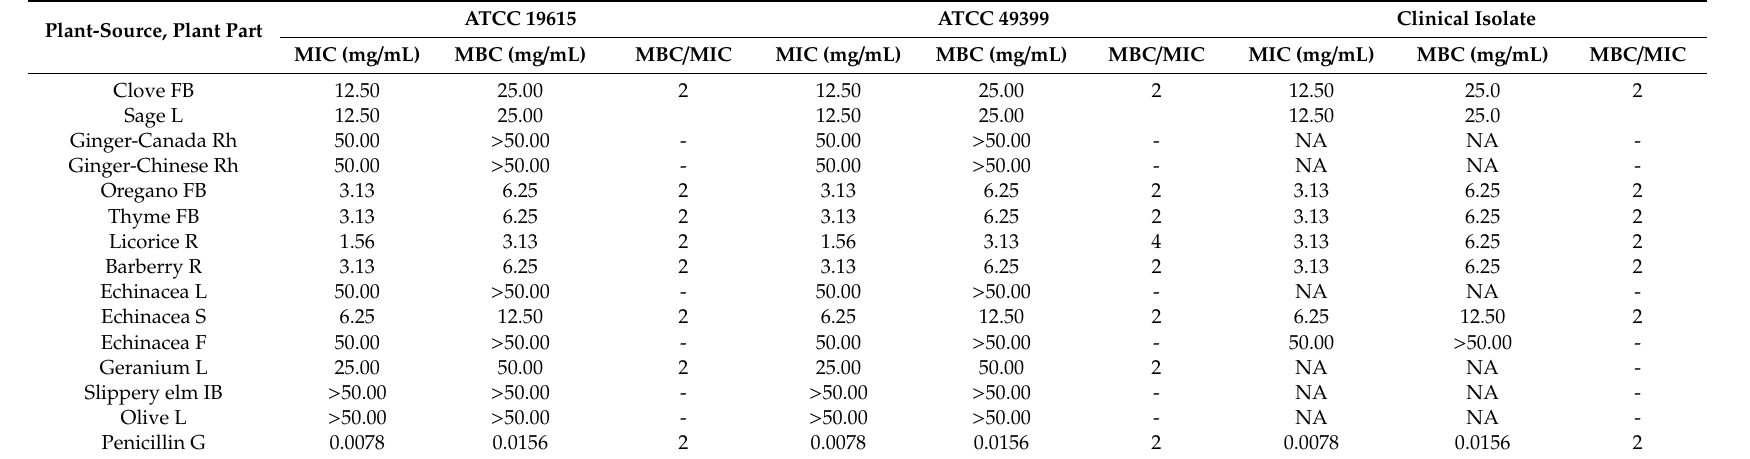
Table 2. The minimum inhibitory concentration (MIC) and minimum bactericidal concentration (MBC) of hot water infusions against three strains of Streptococcus pyogenes . ATCC: American Type Culture Collection. Plant-Source, Plant